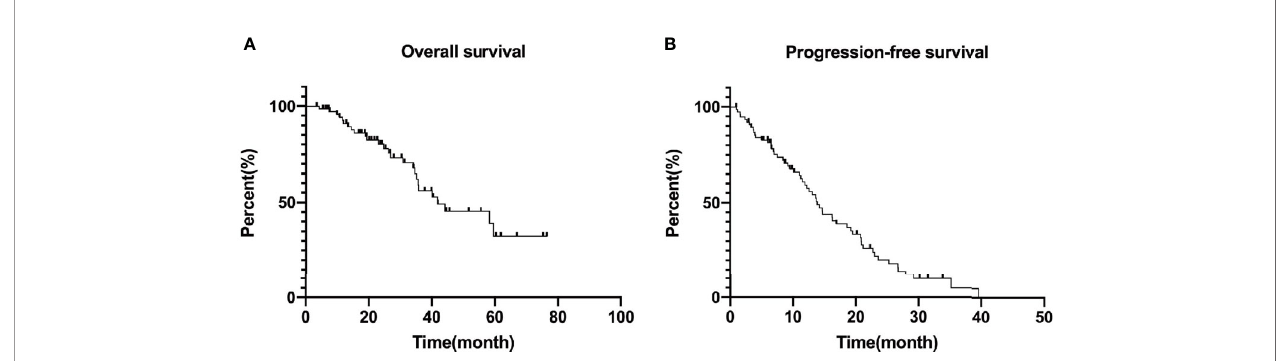
FIGURE 2 | Overall survival (A) and median progression free survival (B) curves of included patients. Progression free survival: 13.87 (95%CI: 11.66 – 16.08) months and Overall survival: 41.47 (95%CI: 20.11 – 62.83) months. The survival rates for 5 years are 91.0, 80.3, 56.1, 45.5, and 32.5%,